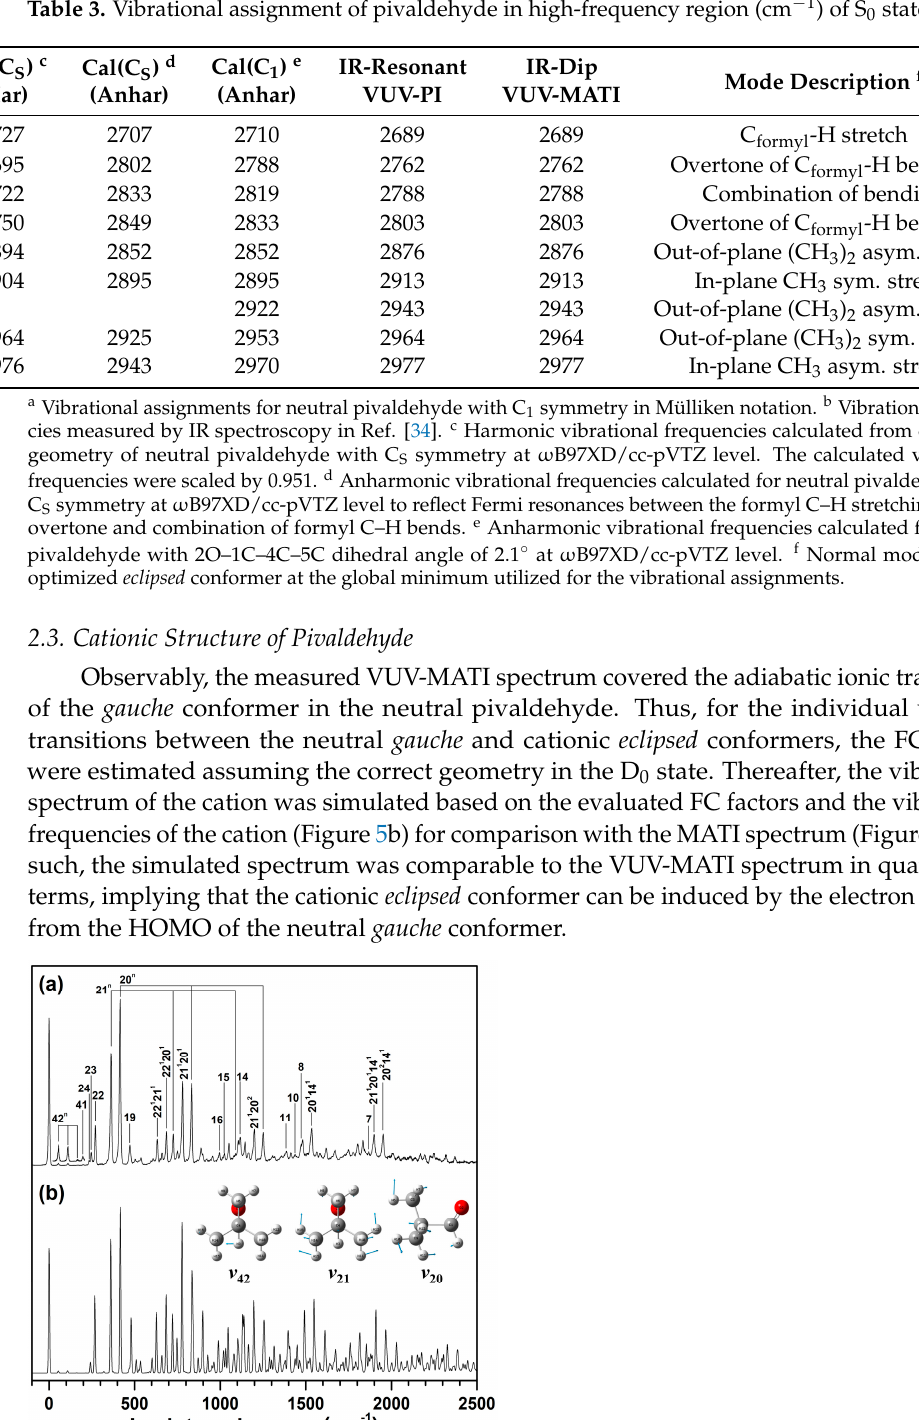
Figure 5. ( a ) HR VUV-MATI spectrum of pivaldehyde, including the vibrational assignments achieved by FC analysis. ( b ) FC simulation spectrum for adiabatic ionic transitions between neutral gauche with 2O–1C–4C–5C dihedral angle of 2.1° and the cationic eclipsed conformers optimized at ω B97XD/cc-pVTZ level for pivaldehyde. Eigenvectors of promoted vibrational modes in cationic state are illustrated in figure.